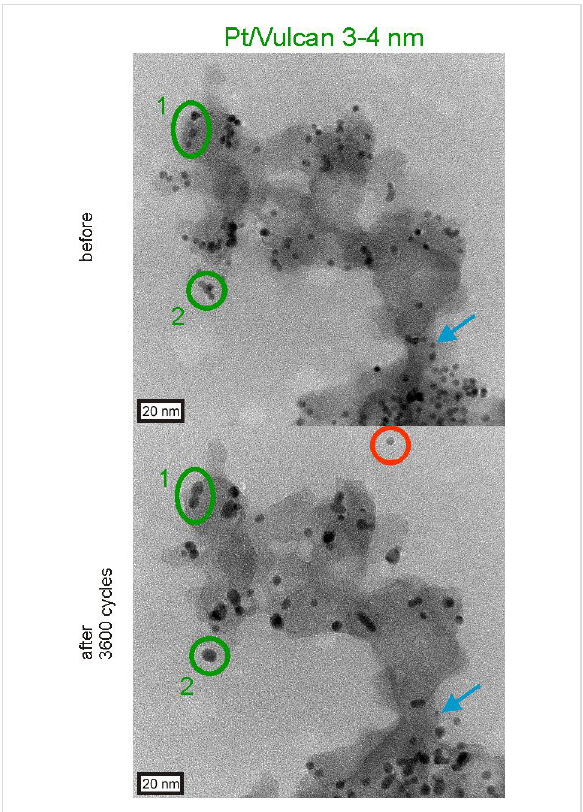
Figure 6: IL-TEM micrographs of Pt/Vulcan 3–4 nm after 0 and after 3600 potential cycles between 0.4 and 1.4 V RHE in 0.1 M HClO 4 (scan rate 1 V·s − 1 , room temperature). Blue, red and green symbols mark dissolving, detached and coalescing platinum particles.